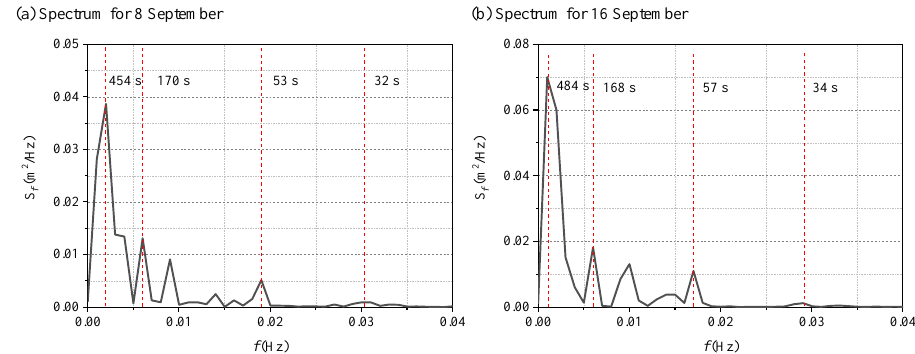
Figure 9. Modeled day-averaged spectra at location sensor G3: ( a ) 8 September and ( b ) 16 Septem- ber. Table 6. Natural periods from measurement and numerical simulation.